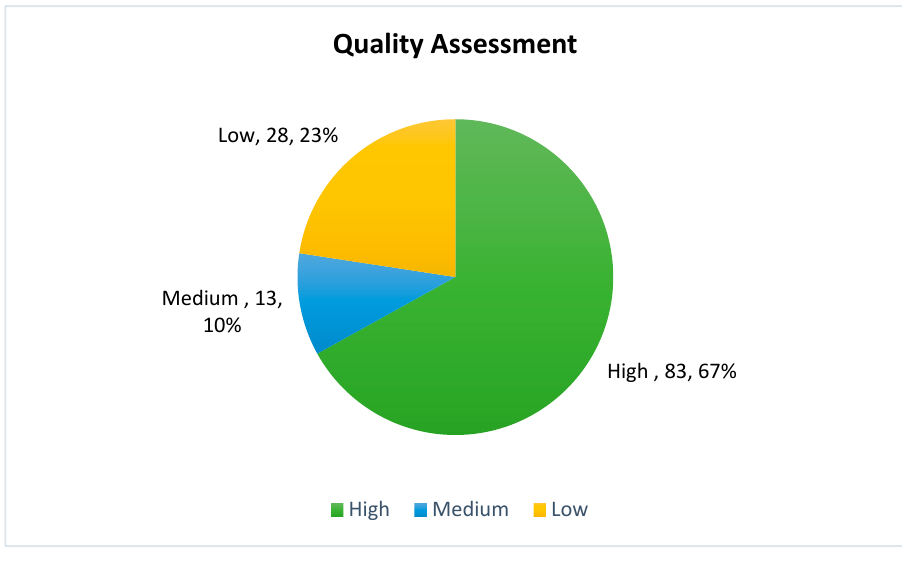
Figure 2. Quality Assessment. Appl. Sci. 2019 , 9 , x FOR PEER REVIEW